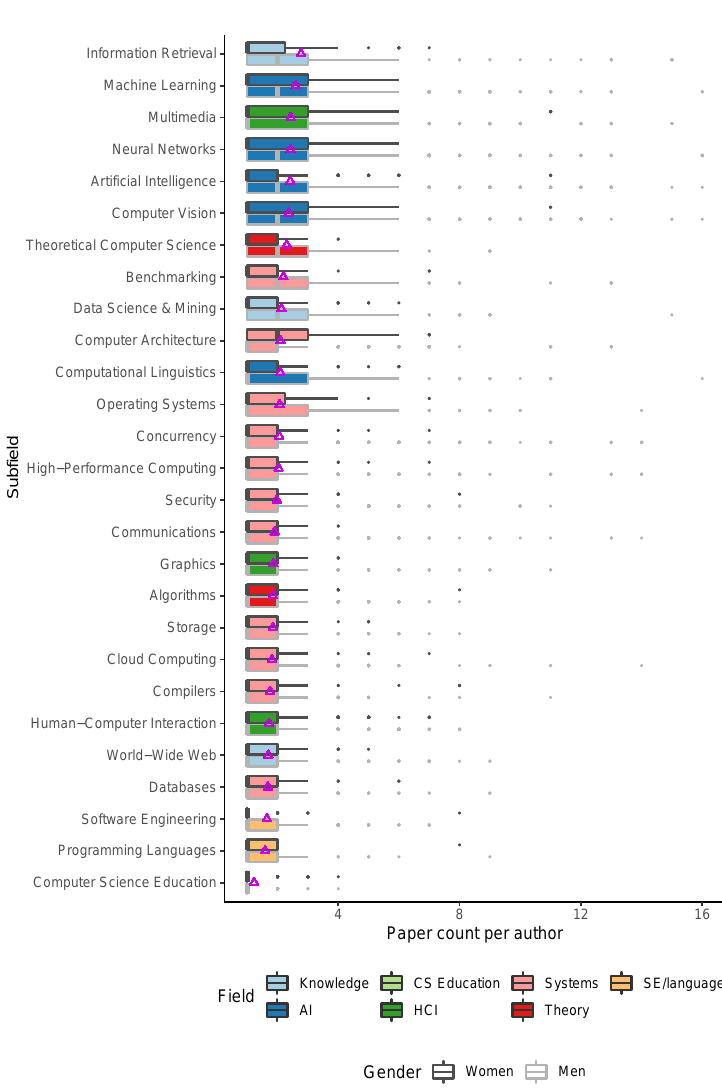
Figure 3. Distribution of number of distinct papers per author by gender, field, and subfield. Each box- plot shows the interquartile range (25–75th percentiles) in the filled box area, with veritcal notches denoting medians. The horizontal lines to the right represent the 75–95th percentile range. Dots fur- ther to the right denote outlier points above the 95th percentile. The top boxplot for each subfield shows the distribution for women, followed by the distribution for men. Triangles represent median values for both genders, which is used for sorting